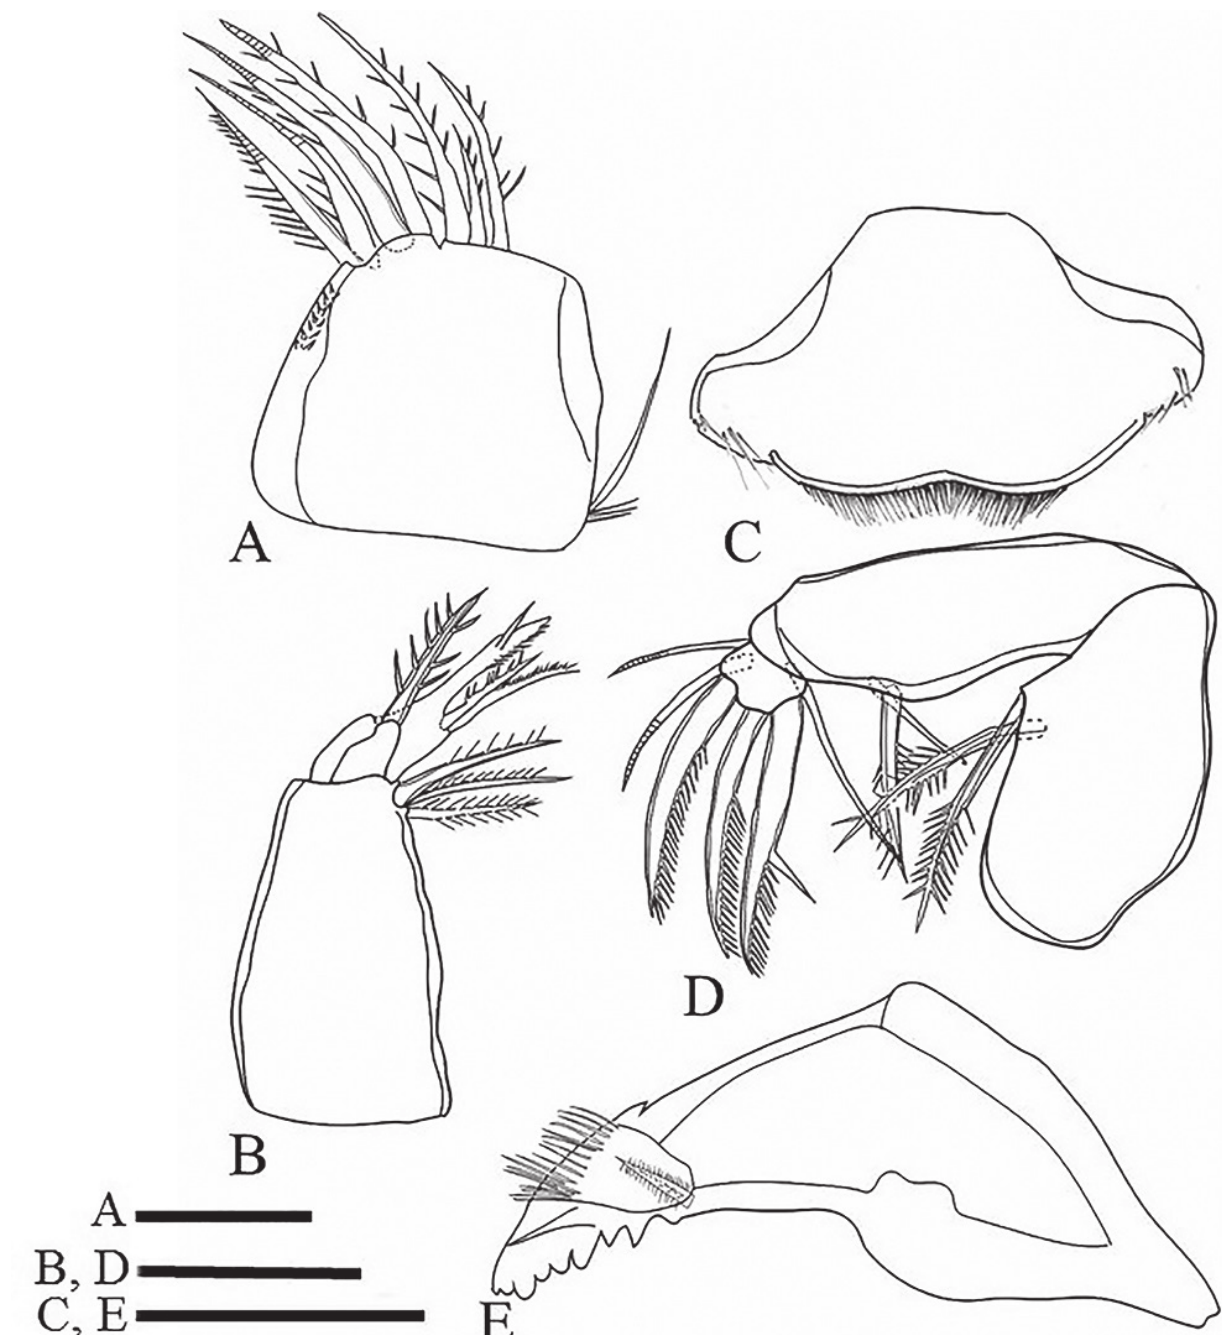
Figure 3. Clausidium persiaensis sp. nov. (female). A, maxillule; B, maxilla; C, labrum; D, maxilliped; E, mandible. Scale bars: A, 50 μm; C, D, 25